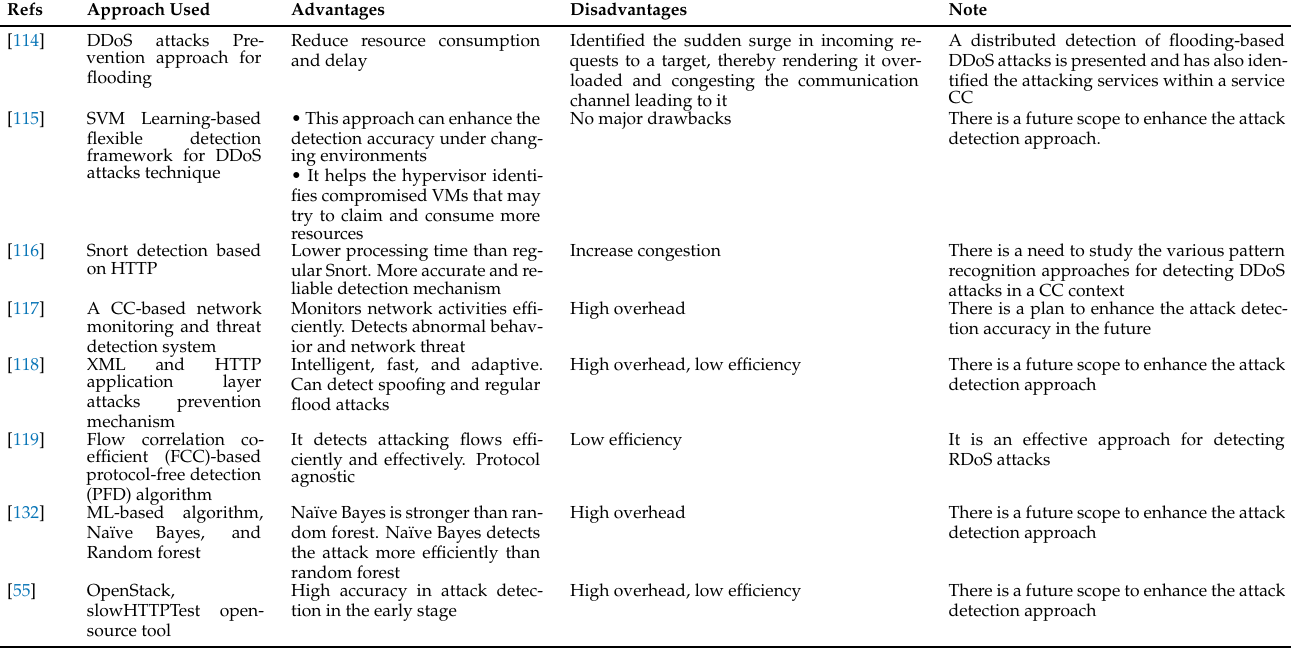
Table 11. Advantages and disadvantages of anomaly-based detection